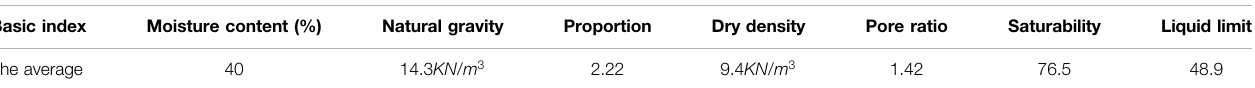
TABLE 2 | Physical properties of fl y ash.